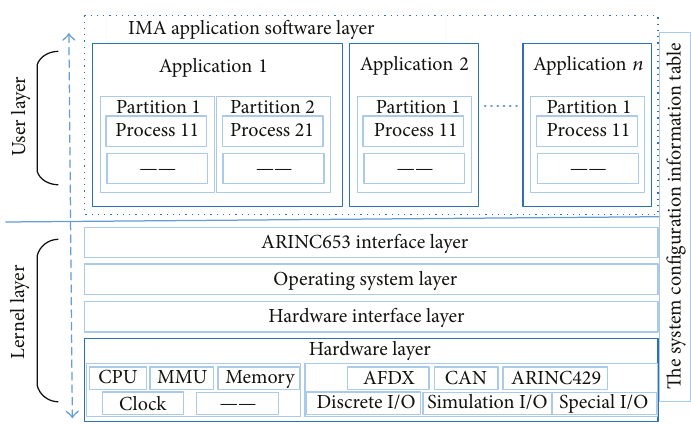
Figure 1: IMA architecture of an ARINC653 system. Table 1: Example of general con fi guration information table of ARINC653